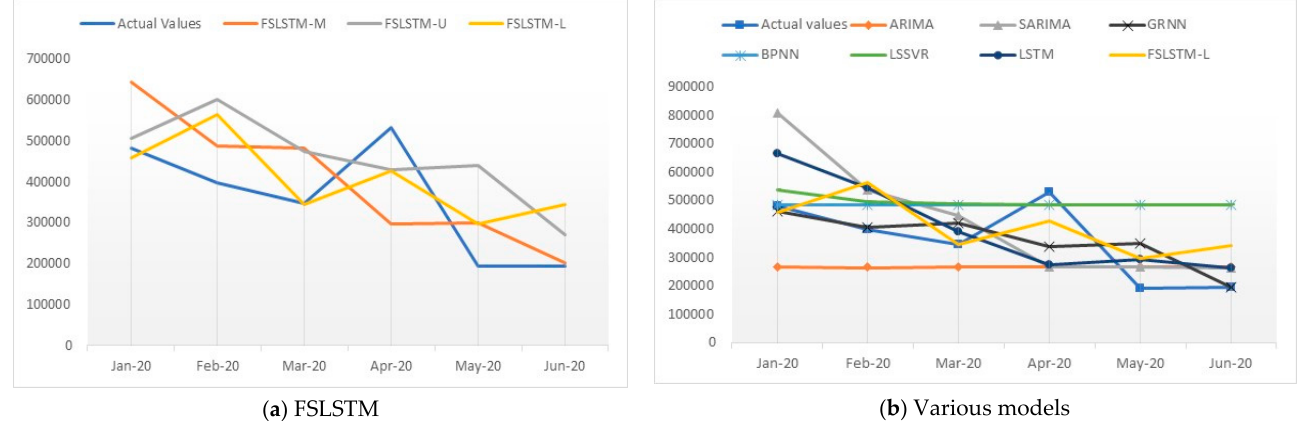
Figure 5. Illustration of the actual and forecasted power outputs of various models for the Shimen wind power plant.